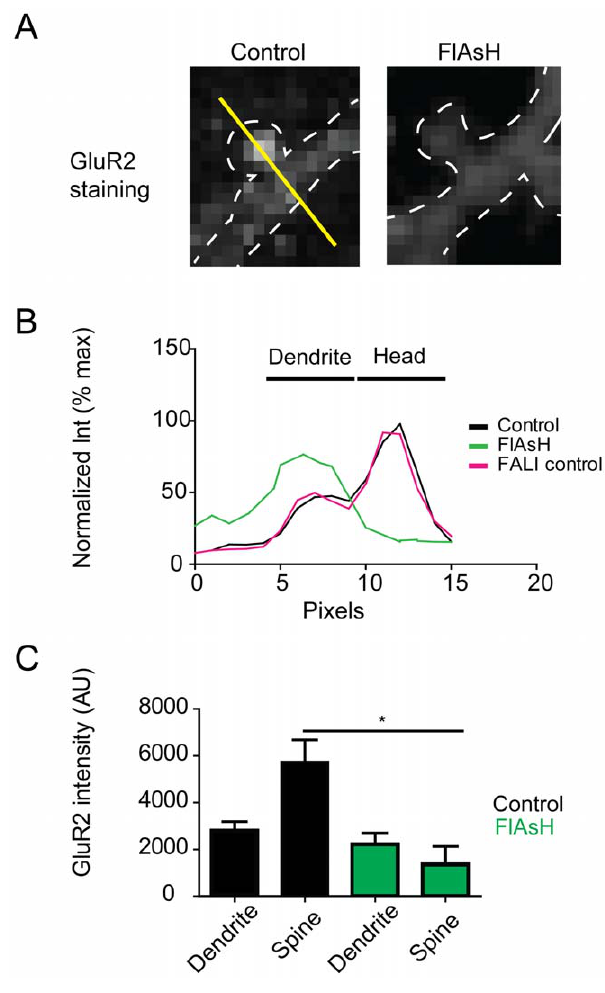
Figure 4. FALI selectively decreases GluR2 immunostaining in spines. (A) Hippocampal cells were infected with PSD-95-4c and FALI experiments were performed as described. GluR2 localization was measured by immunostaining in control and FlAsH treated cells. Line- scans were drawn through spines and dendrites (yellow line) to measure fluorescent intensity in controls before and after FALI. (B) Fluorescence intensities were normalized to the maximum intensity and plotted versus distance in control (no illumination), FALI control (illumination, no FlAsH) and FlAsH cells. (C) GluR2 intensity was significantly reduced in spines after FALI when compared to spines in control experiments (n=4 cells in all conditions, 43 spines for control and 35 for